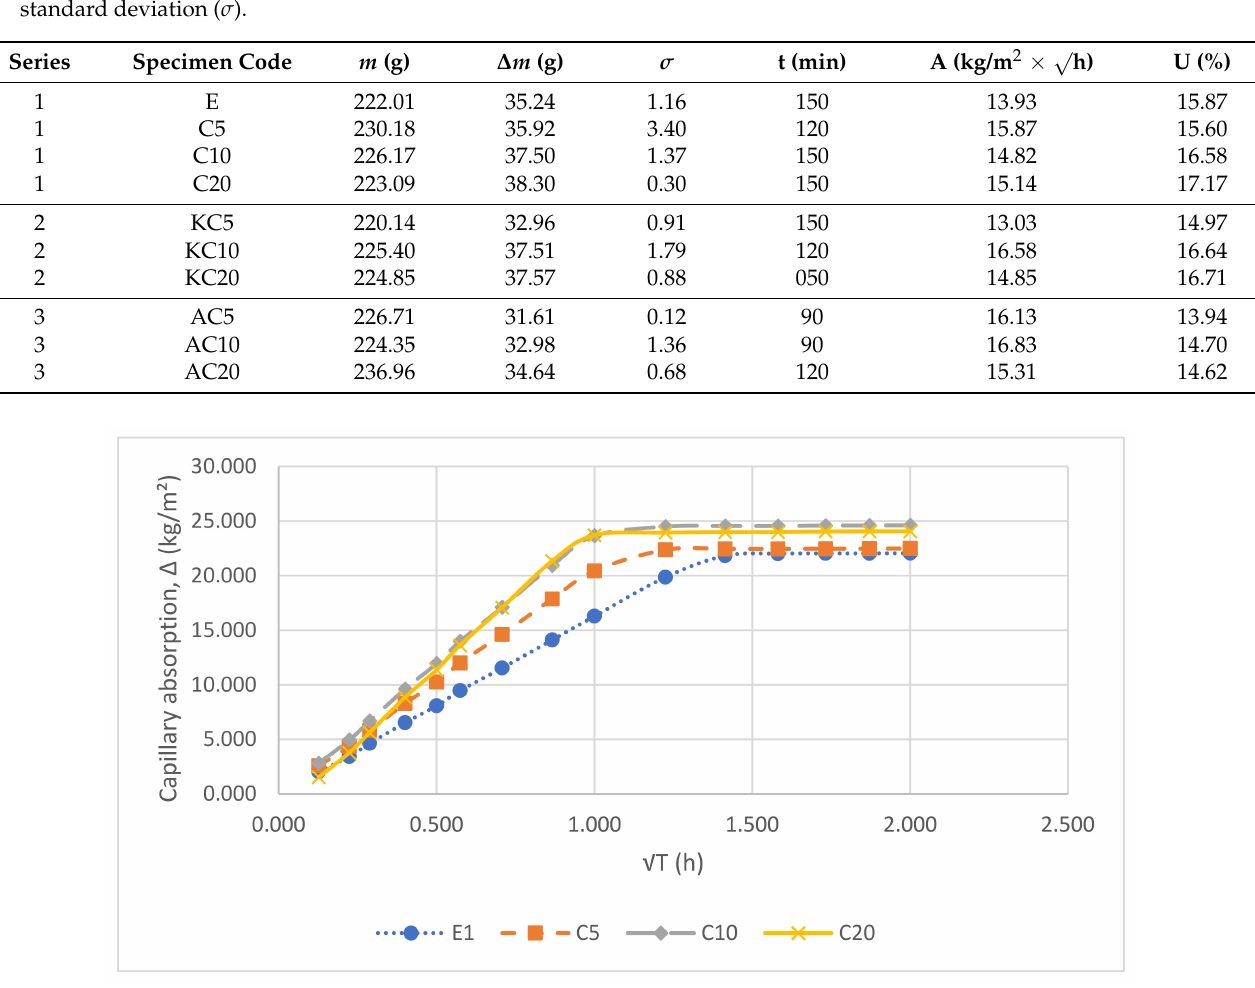
Figure 10. Capillary water absorption in Series 1 (same w/b ratio, different percentage of WPC).